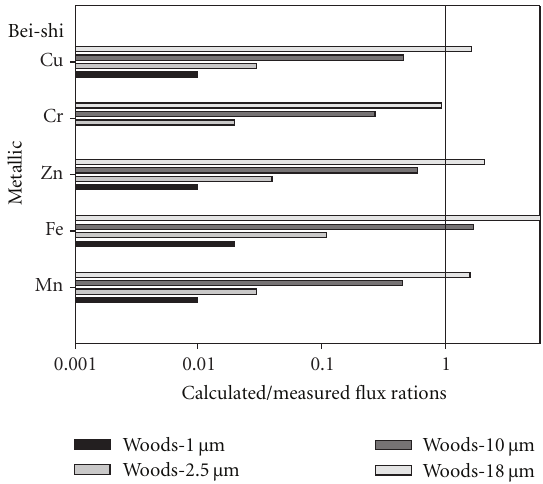
Figure 3: It displays the average calculated/measured flux ratios by using Woods models in the prediction of ambient air metallic elements dry deposition for various particle sizes (1 μ m, 2.5 μ m, 10 μ m, and 18 μ m) at Bei-shi sample